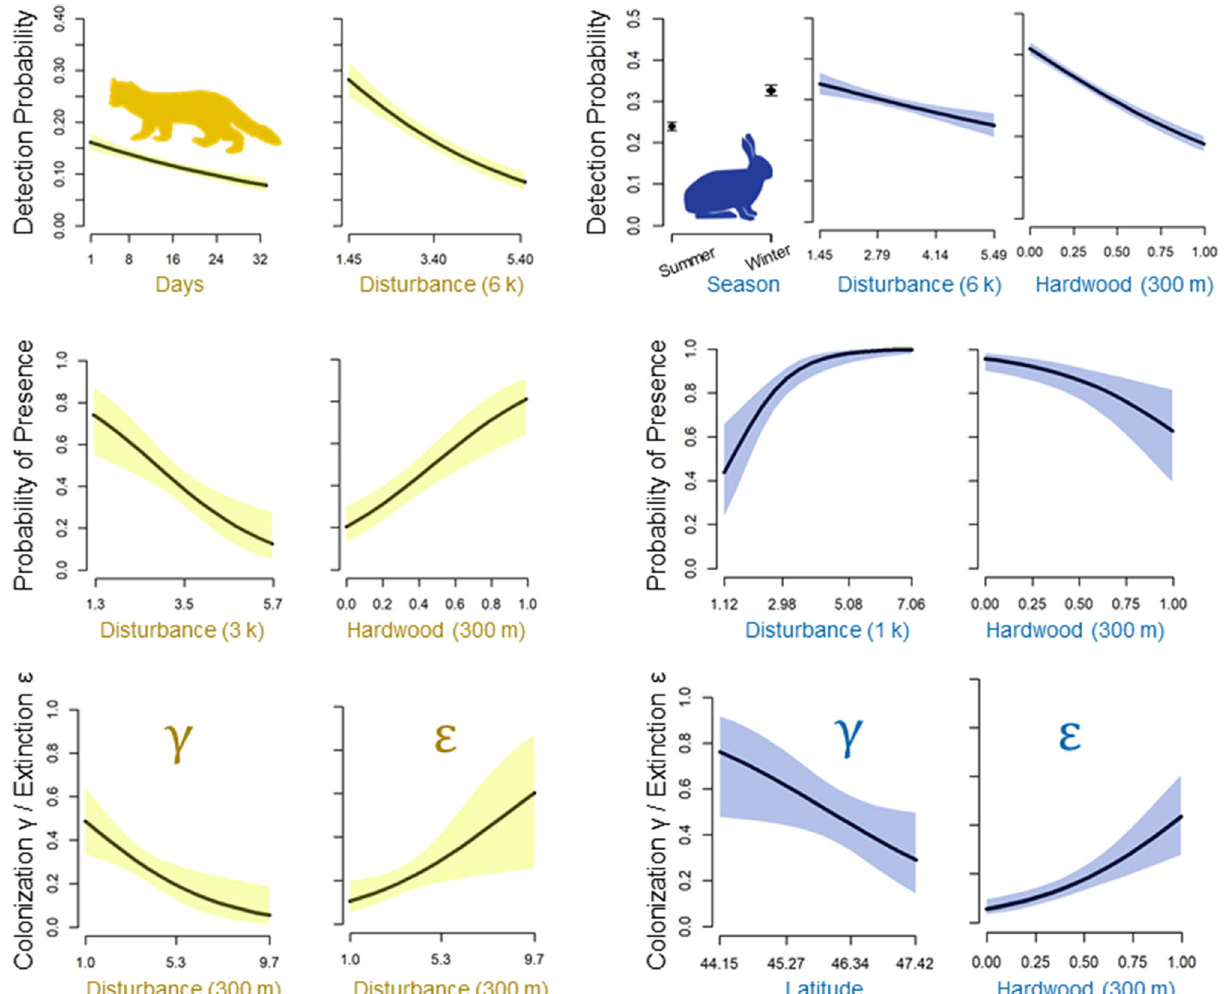
Figure 2. Predictions from the top ranked multi-season occupancy models from 197 camera survey stations deployed in Maine, USA. (Left) Marten ( Martes americana ) probability of detection is negatively related to forest disturbance intensity (6 k buffer), and days since the start of the survey. Marten initial occupancy (probability of presence) is negatively related to disturbance (3 k), and positively related to the proportion of hardwood (300 m buffer). Marten local extinction probability (ε) is more likely with increased disturbance (300 m buffer), and colonization probability is less likely in more disturbed areas. (Right) Snowshoe hare ( Lepus americanus ) probability of detection is higher in winter and decreases with disturbance intensity (6 k buffer) and the proportion of hardwood (300 m buffer). Snowshoe hare initial occupancy was negatively related to the proportion of hardwood and positively related to disturbance (1 k buffer). The probability of colonization (γ) decreases with latitude and the probability of local extinction increases with the proportion of hardwood (300 m buffer). The shaded are includes the 95% CI. Results for other species are shown in Fig.